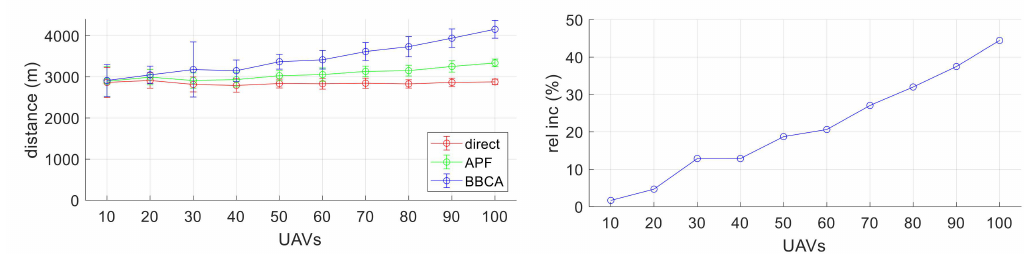
Figure 16. Multi-UAV study: distance covered; average and standard deviation values (left) and relative increment of BBCA related to “direct”